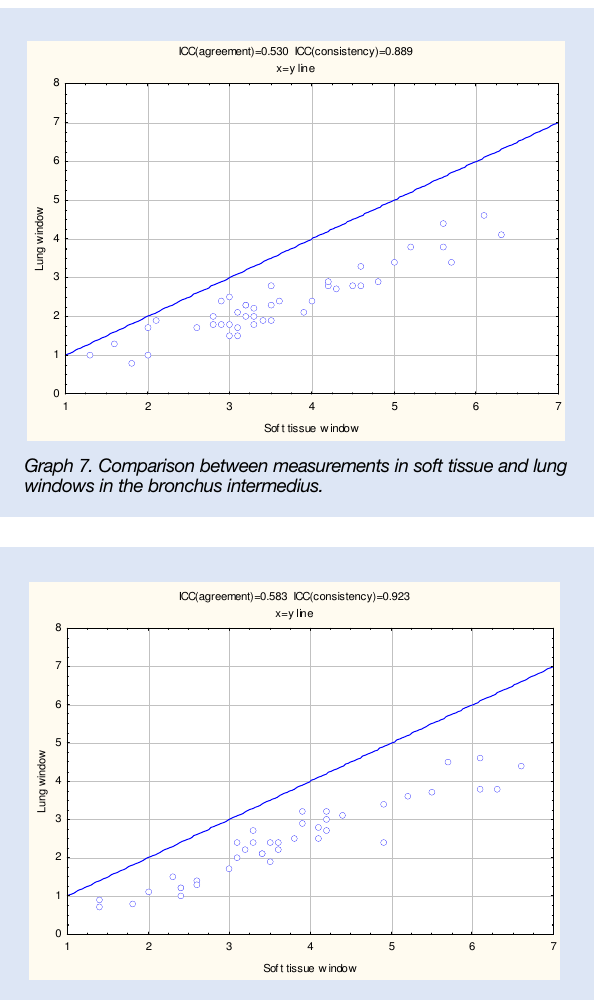
Graph 8. Comparison between measurements in soft tissue and lung windows in the left main bronchus.